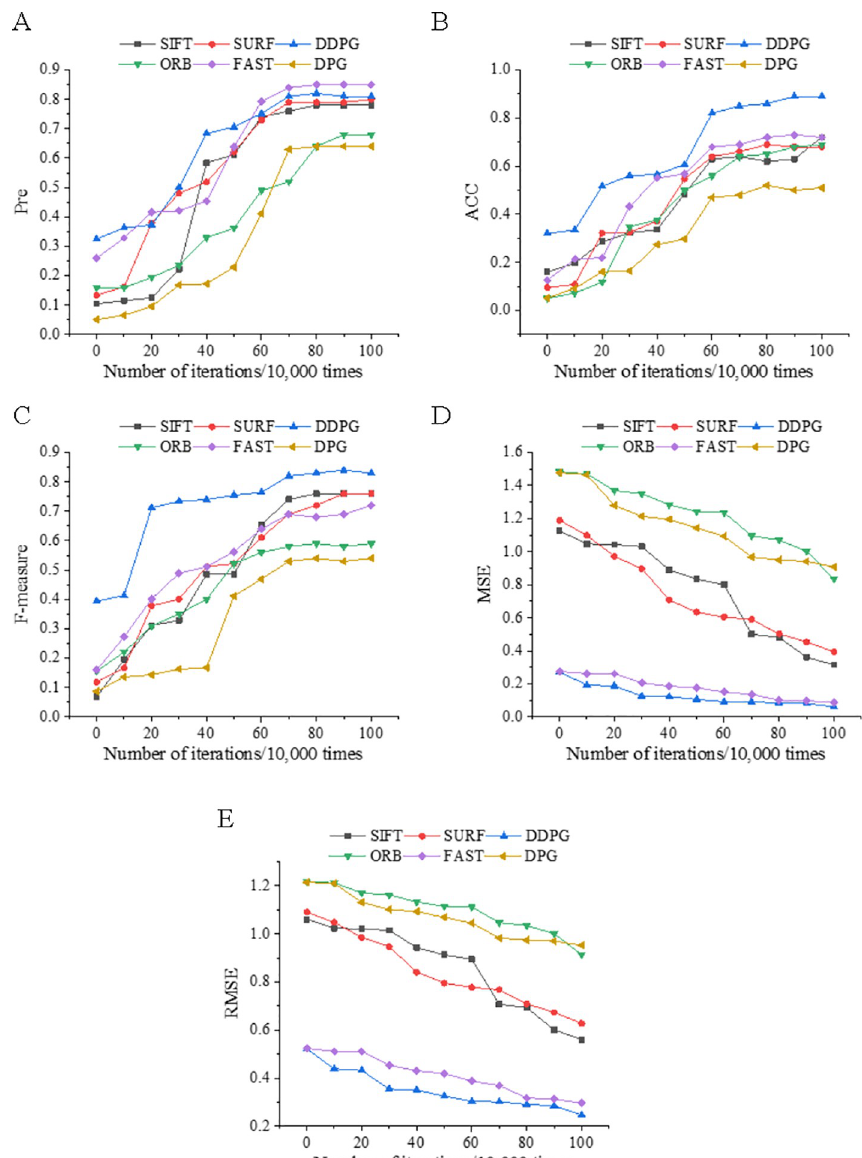
Fig 8. Feature extraction results based on deep reinforcement leaning. Note: common feature extraction algorithms include SIFT (Scale Invariant Feature), SURF (Speeded Up Robust Feature), ORB (ORiented Brief), FAST, and DPG (Deterministic Policy